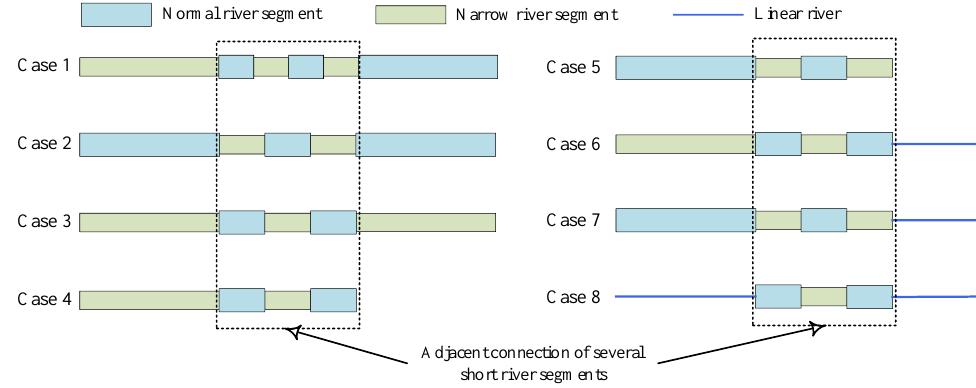
Figure 8. Cases of non-isolated short river segment.